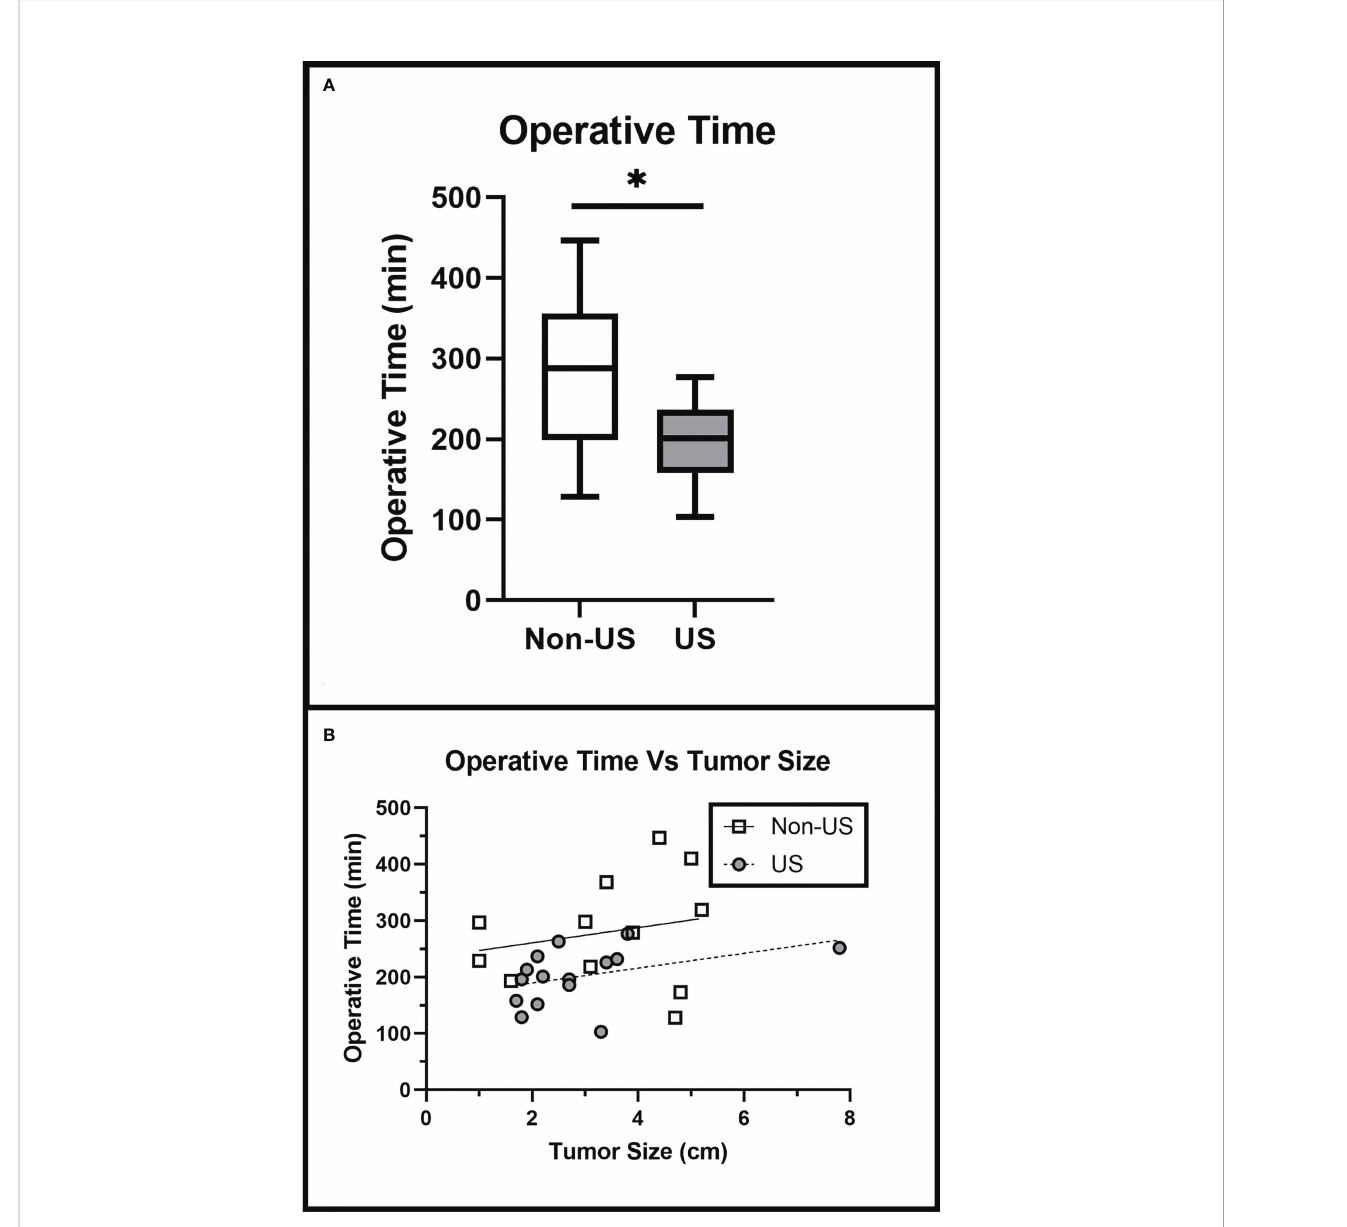
FIGURE 4 Operative Time is Reduced with the Use of IOUS: (A) IOUS signi fi cantly reduced procedure duration (p = 0.011). (B) IOUS reduced operative time when adjusted for tumor size (Slope p = 0.7991, Intercept p < 0.0001). Asterisks (*) indicate a signi fi cance of p < 0.05. Crosses (+) indicate mean